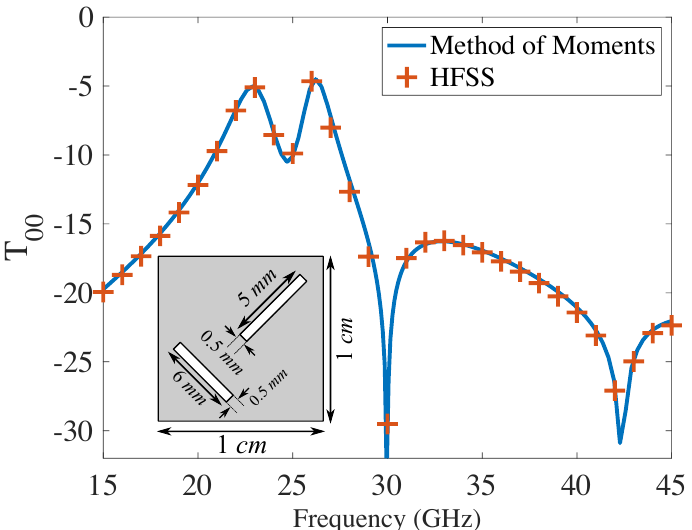
Figure 2. Copolar transmission coefficient comparison between the method presented here and that obtained from the commercial software HFSS. The unit cell is depicted in the inset, containing two slots with l s 1 = 6mm, l s 2 = 5mm, w s 1 = w s 2 = 0.5mm, x c 1 = y c 1 = 2.5mm, x c 2 = y c 2 = 7.5mm, α 1 = π /4, α 2 = − π